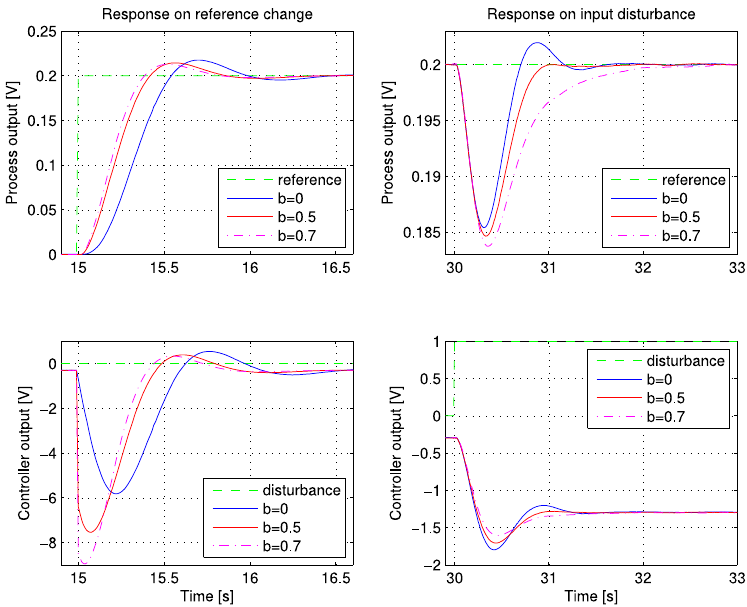
Figure 18. Closed-loop response of control system for charge-amplifier drift compensation.